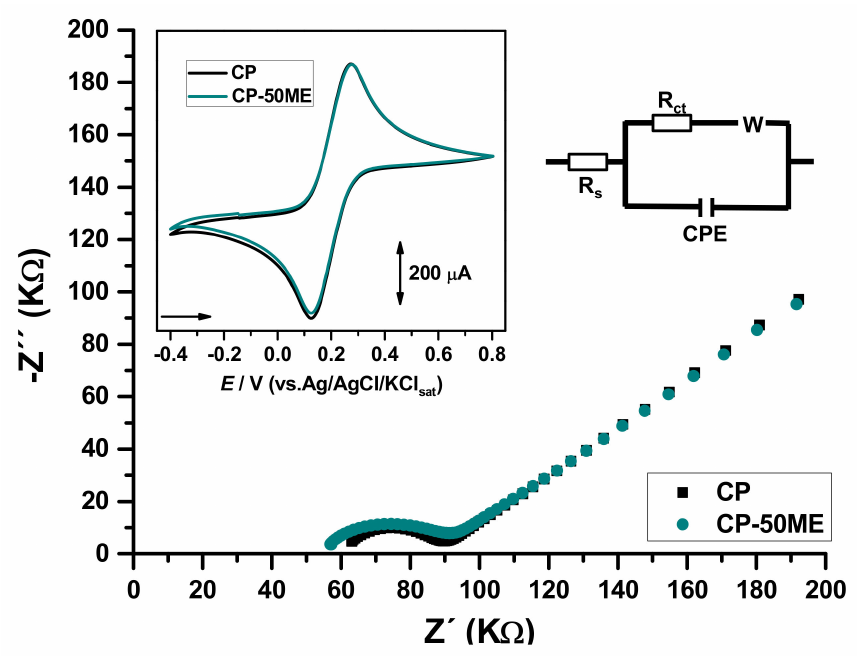
Figure 2. Nyquist plots for CP and CP-50ME. Inset: Cyclic voltammograms at. All analyses were carried out in 0.1 M KCl solution containing 50 mM K 4 (Fe(CN) 6 )/K 3 (Fe(CN) 6